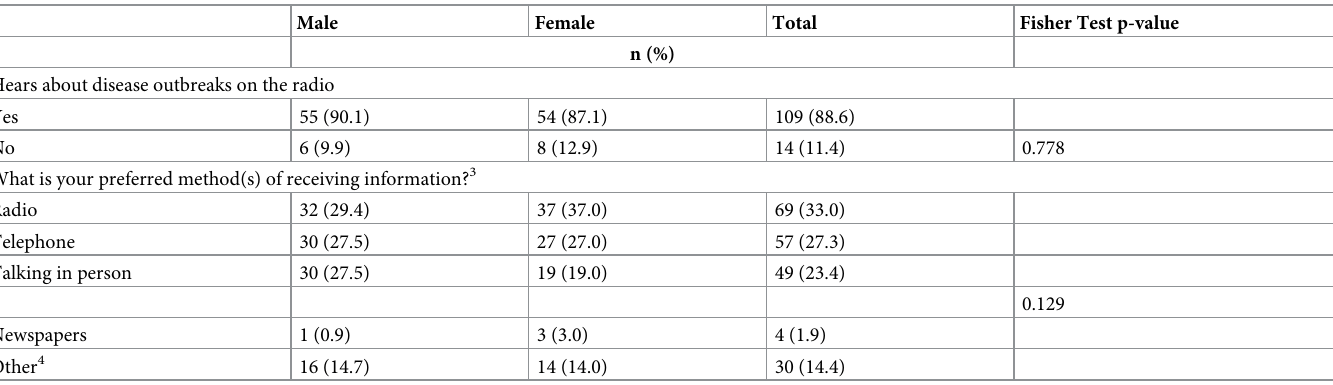
Table 5. Preferred sources of information among respondents in Nyagatare District, Rwanda (N = 123).